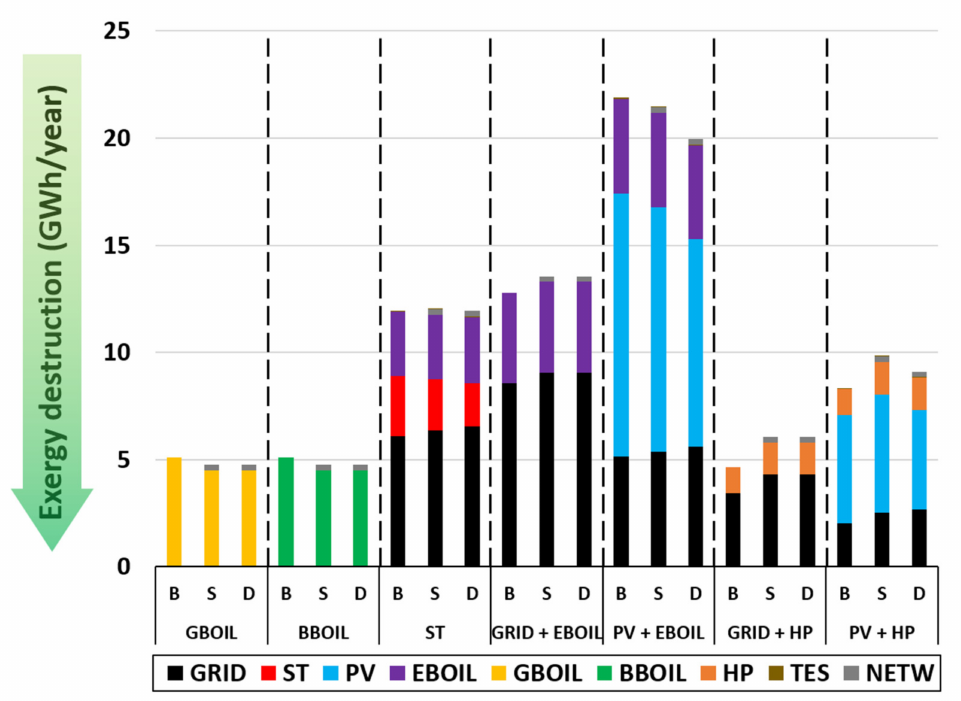
Figure 6. Exergy destruction, overall and unit-by-unit, for every solution at every